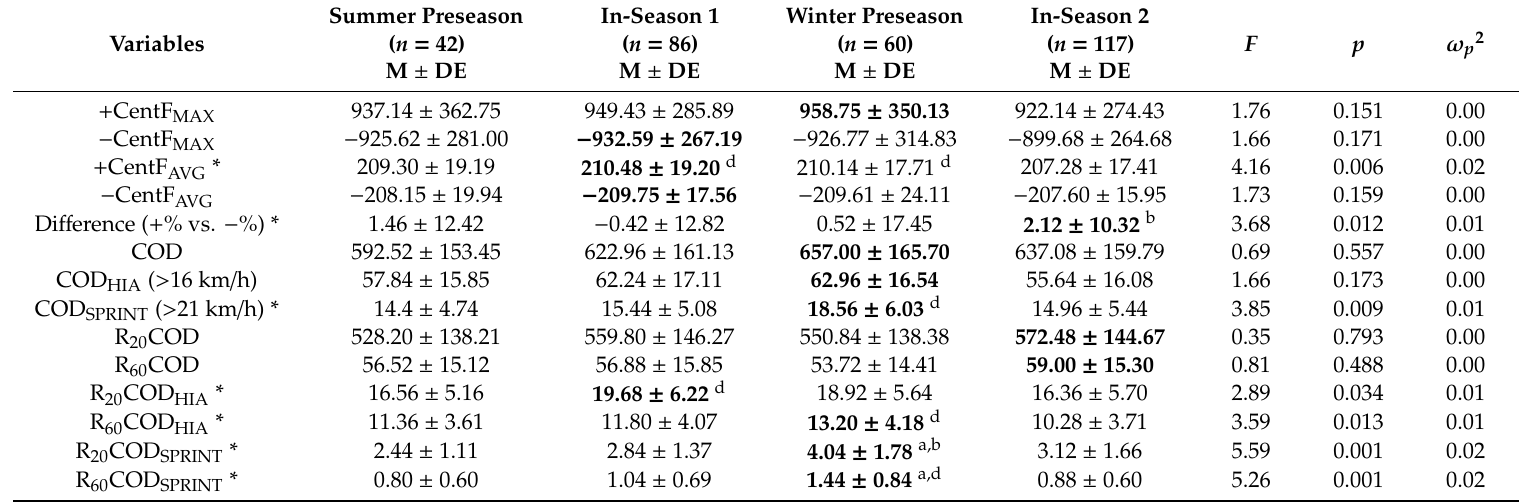
Table 2. Descriptive and comparative analysis of centripetal force and changes of direction related to the period of the season.